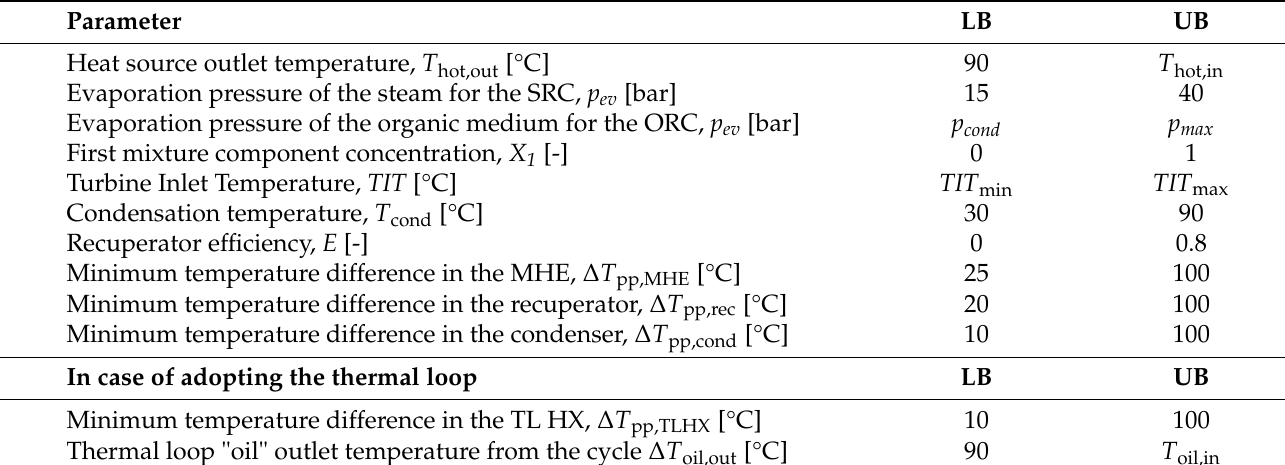
Table 7. Upper and lower bound used in the optimization of both SRC and ORC